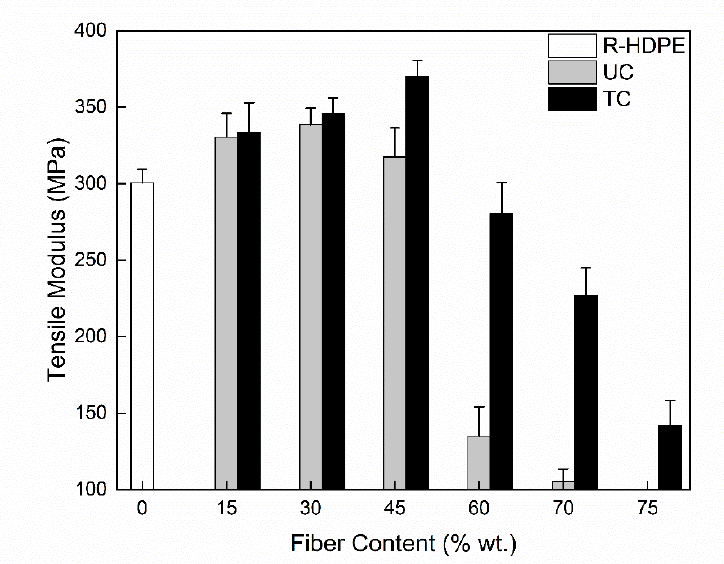
Figure 11. Tensile modulus of the recycled high-density polyethylene (R-HDPE), untreated (UC) and treated (TC) composites as a function of fiber content.